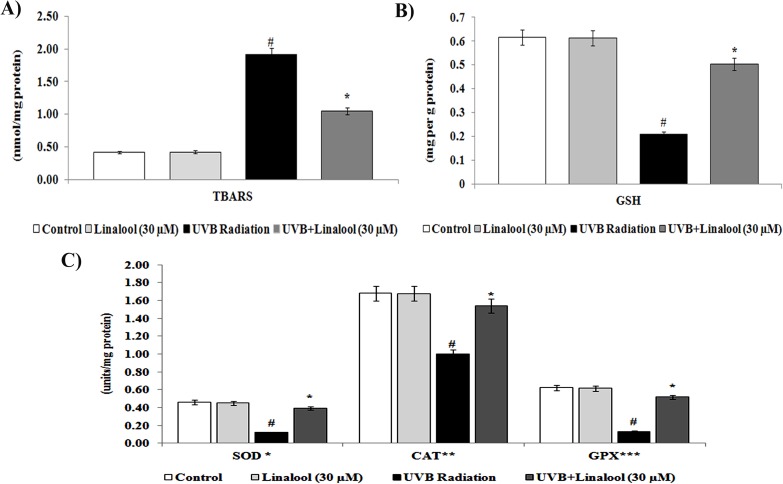
Effect of linalool on UVB-induced lipid peroxidation and antioxidant status in skin cells.(A) Lipid peroxidation status of linalool and/or UVB irradiated HDFa cells. TBARS expressed as nmol/mg protein (B) GSH level of linalool and/or UVB irradiated HDFa cells. GSH level was expressed as mg/g protein (C) Enzymatic antioxidants status of linalool and/or UVB irradiated HDFa cells. *Enzyme concentration required for 50% inhibition of nitroblue tetrazolium reduction in one minute. **μmol of hydrogen peroxide consumed per minute. ***μg of glutathione consumed per minute. Values are given as means ± SD of six experiments in each group. Values not sharing a common marking (# and *) differ significantly at P = 0.05 (DMRT).